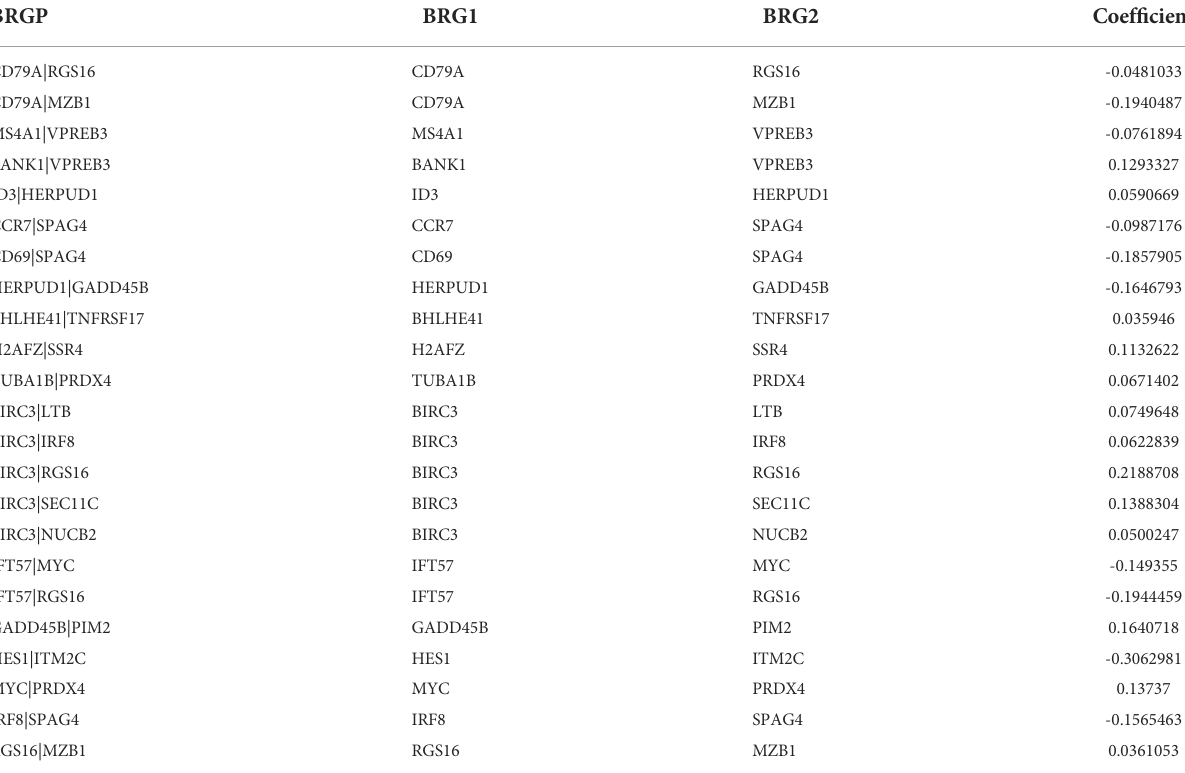
TABLE 2 B cell-related gene pairs used for construction of prognostic risk model.